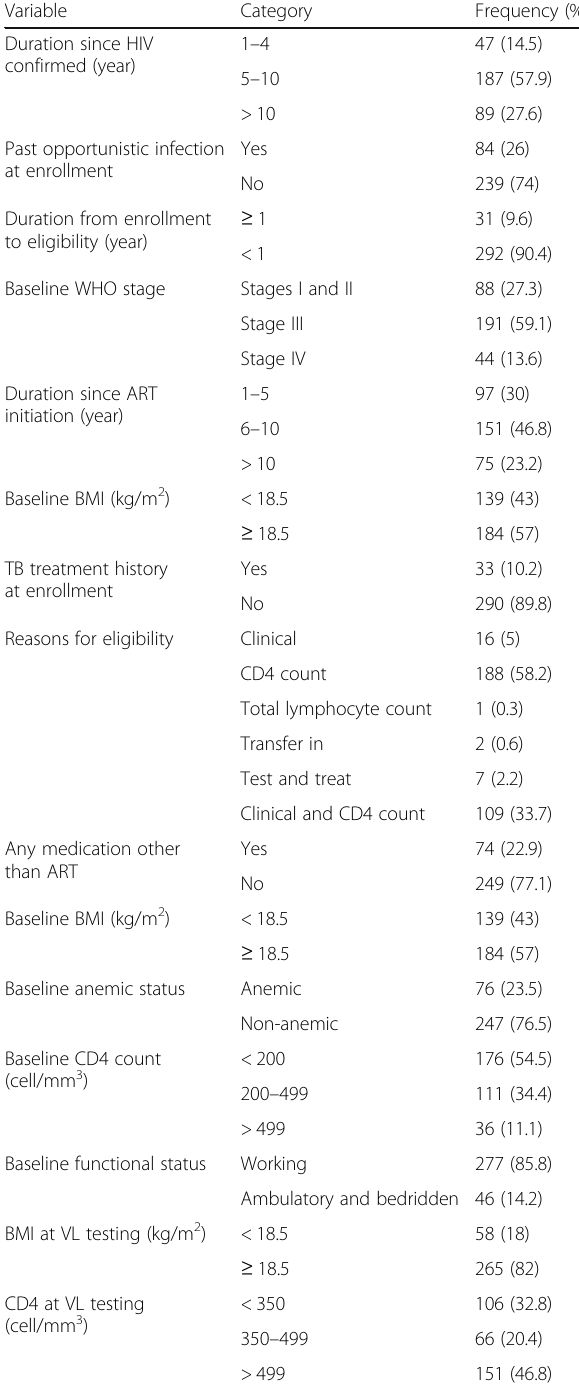
Table 1 Clinical- and treatment-related characteristics of HIV- infected adults on HAART at the University of